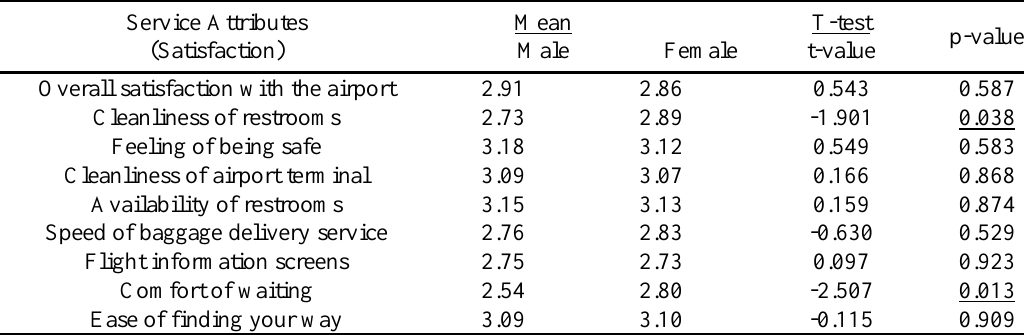
Table 4. Passengers’ satisfaction with level of